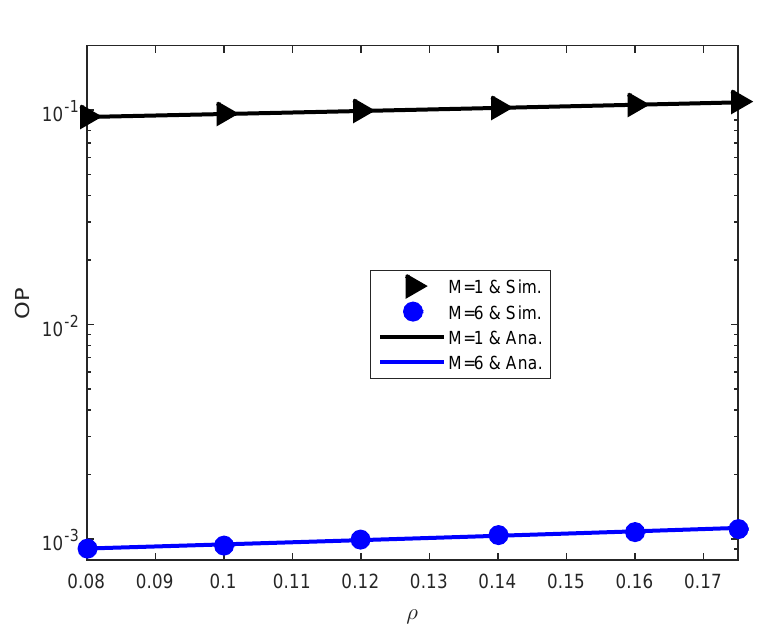
Figure 2. OP versus ¯ P .